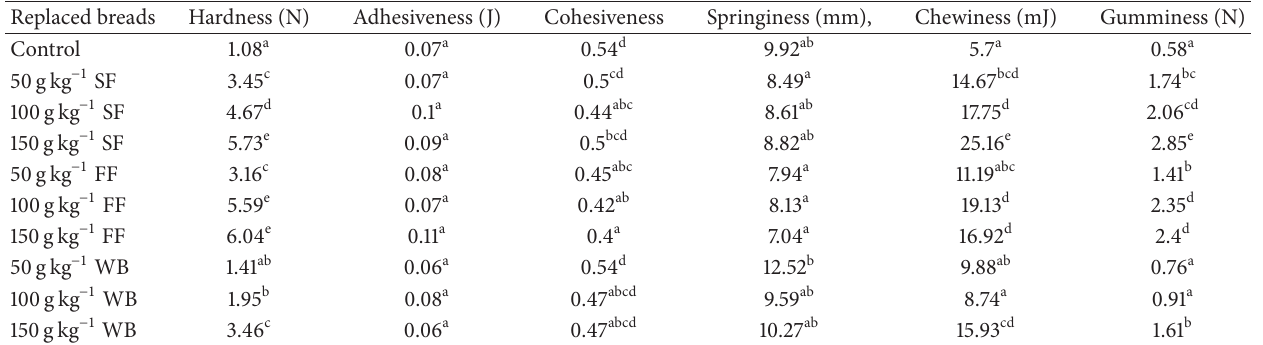
Table 5: Texture parameters of loaves replaced with FF, SF, and WB (50, 100, and 150 g kg −1 ) and control a . Replaced breads Hardness (N)